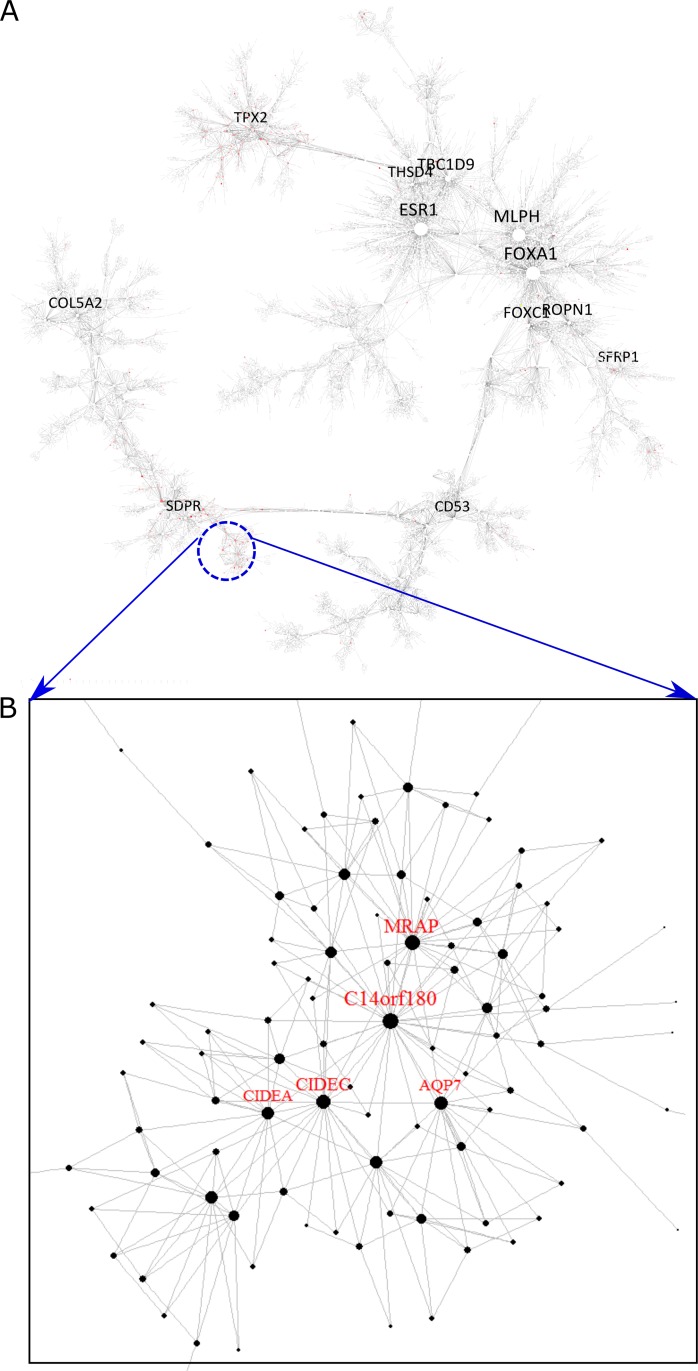
Identification of the adipocytokine-enriched cluster, comp1_56, which was specifically identified by MEGENA.A) The Global BRCA PFN. The nodes in red represent the genes that is predictive of overall survival of LumB patients (Cox p-value <0.05). The blue circle indicates the location of the cluster comp1_56. B) A magnified view of the cluster comp1_56. The nodes with labels are the hubs of the cluster.